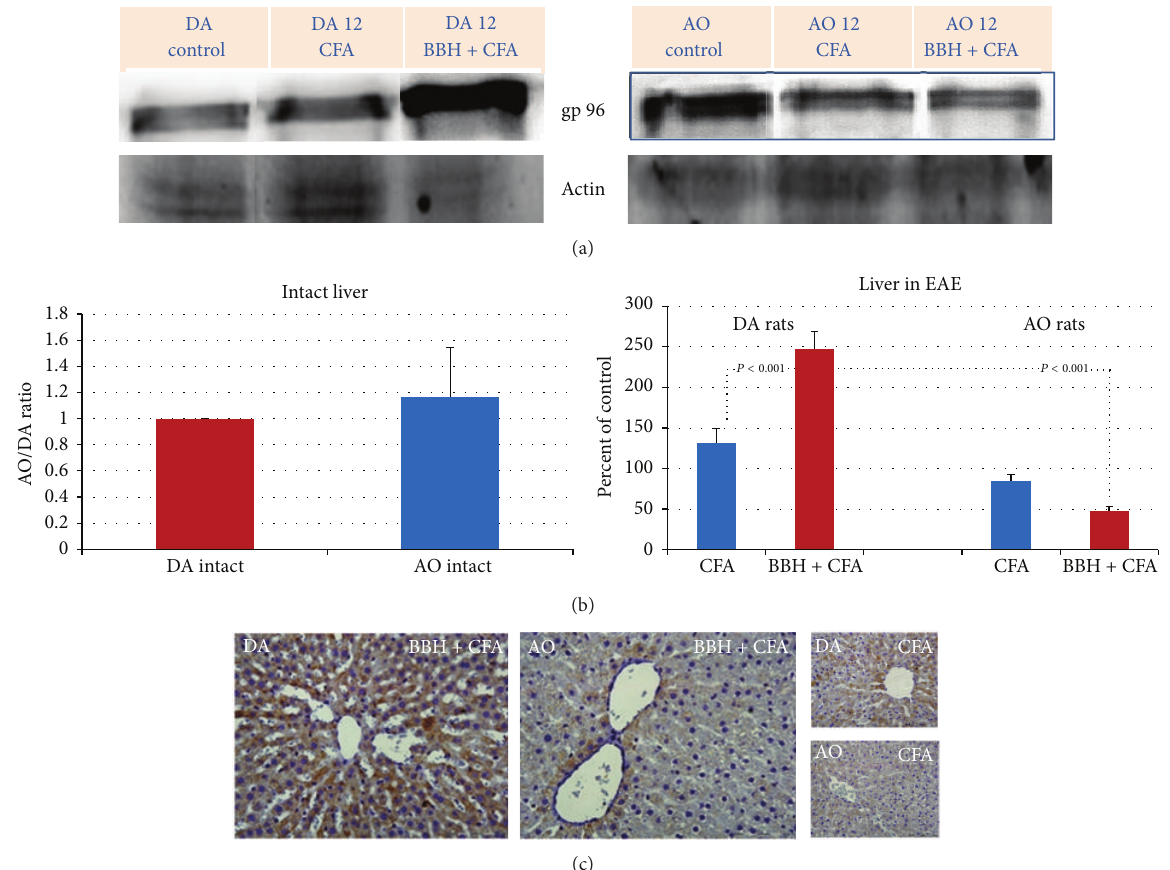
Figure 2: Expression of gp96 in the livers of EAE-prone DA and EAE-resistant AO rats. (a) Representative western blots indicate the gp96/GRP94 protein ( ∼ 200 kD; range 150–200 kD), detected by MoAb to Grp94/gp96 (clone 9G10) under a nonreducing condition in SDS- PAGE. Liver samples were obtained from intact rats and from rats treated by bovine brain homogenate (BBH) and complete Freund’s adjuvant (CFA) or by CFA at the time of first attack in EAE-prone rats (day 12). As a loading control the blots of 𝛽 -actin protein (37–50 kD) are shown. (b) Relative protein expression is shown as AO/DA ratio (intact liver) and as the percent of control (liver in EAE). All band densities were normalized corresponding to 𝛽 -actin. Analyses were made in tissue samples, prepared as a pool from 3 rats in three independent experiments. Data represent mean ± SE. (c) Representative immunohistochemical staining of gp96 protein in paraffin-embedded sections of the liver tissue in DA and AO rats after treatment with BBH+CFA or CFA. The results are representative findings of 3